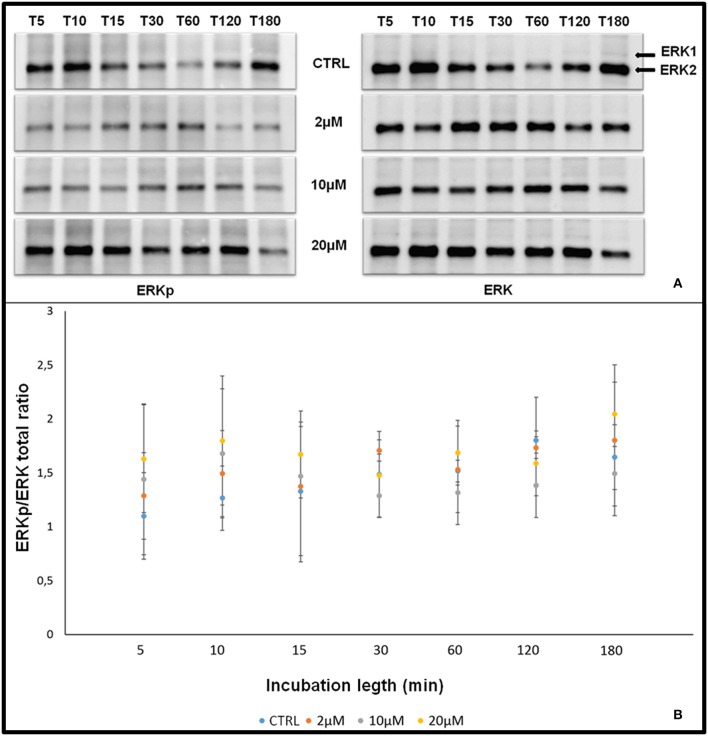
Effect of Aminopurvalanol A treatment on P-Erk/total Erk ratios. Graph showing the effect of of different times of incubation [5 min (T5), 10 min (T10), 15 min (T15), 30 min (T30), 1 h (T1h), 2 h (T2h), 3 h (T3h)] and Aminopurvalanol A concentration on P-Erk/total Erk ratios. The significance of the differences was determined by one-way ANOVA (P > 0.05 for all P-Erk/total Erk ratios vs. CTRL).